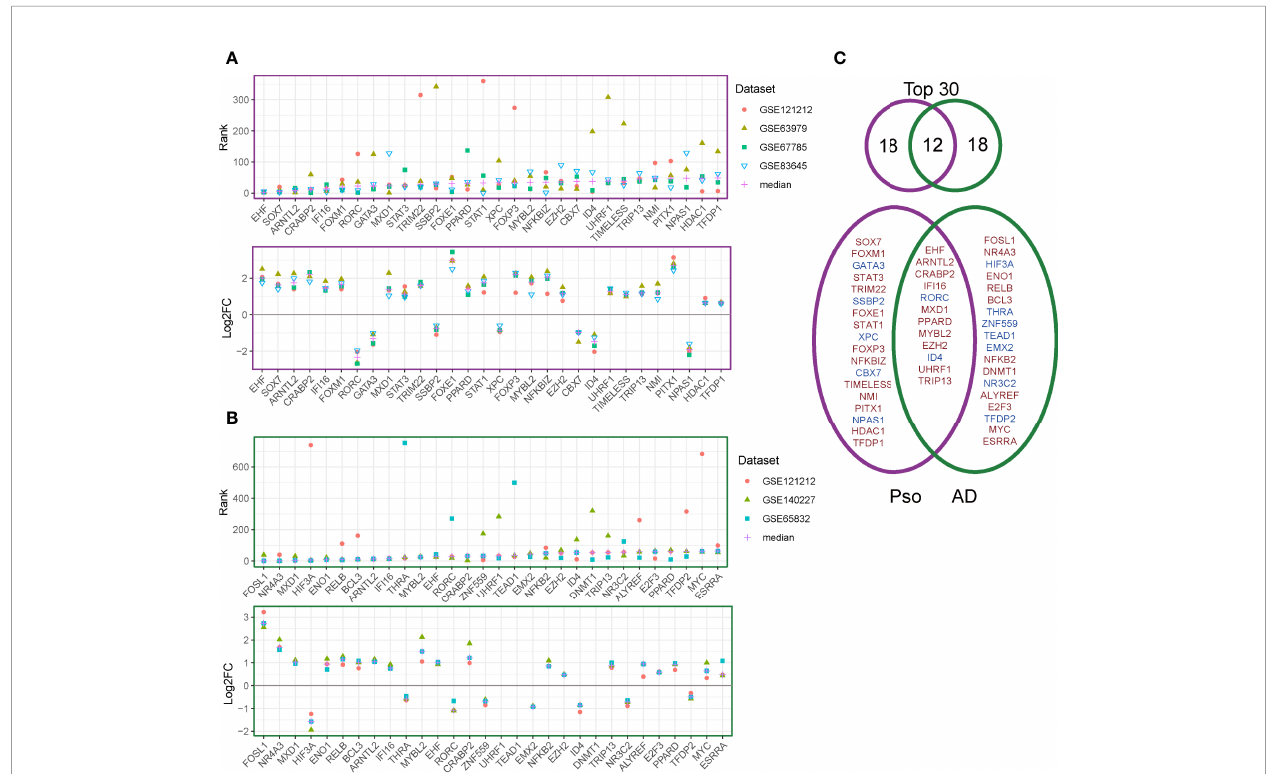
FIGURE 3 | Regulator discovery on publicly available datasets. (A) The ranks (upper panel) and log2 fold change (between lesional and non-lesional skin) (lower panel) of the top 30 regulators in the psoriasis datasets. (B) The ranks (upper panel) and log2 fold change (between lesional and non-lesional skin) (lower panel) of the top 30 regulators in the AD datasets. (C) Venn diagram for the overlapping and disease-speci fi c regulators in psoriasis and AD. Regulators given in red denote up-regulated genes and those in blue denote down-regulated